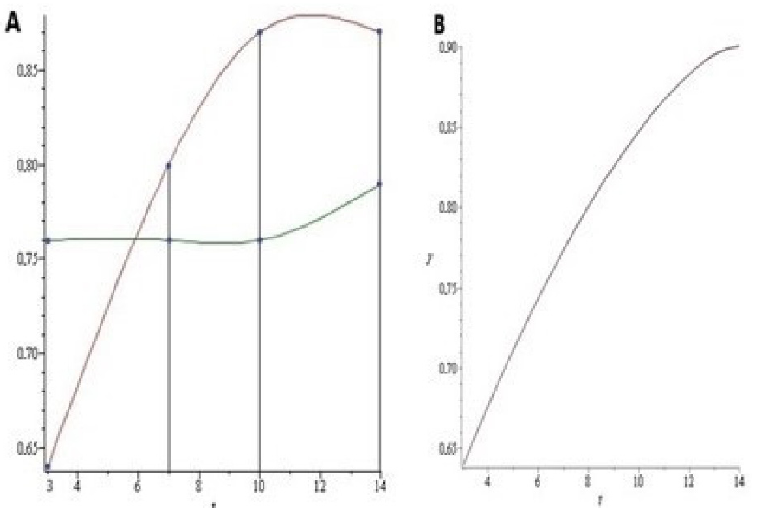
Figure 7. ( A ) Anxiety index of stressed rats (red points) and control rats (green points) during the post-stress period. The points have been connected by spline interpolation (red and green lines). ( B ) Anxiety index predicted by the mathematical model for the stressed rats is illustrated by a continuous red line.